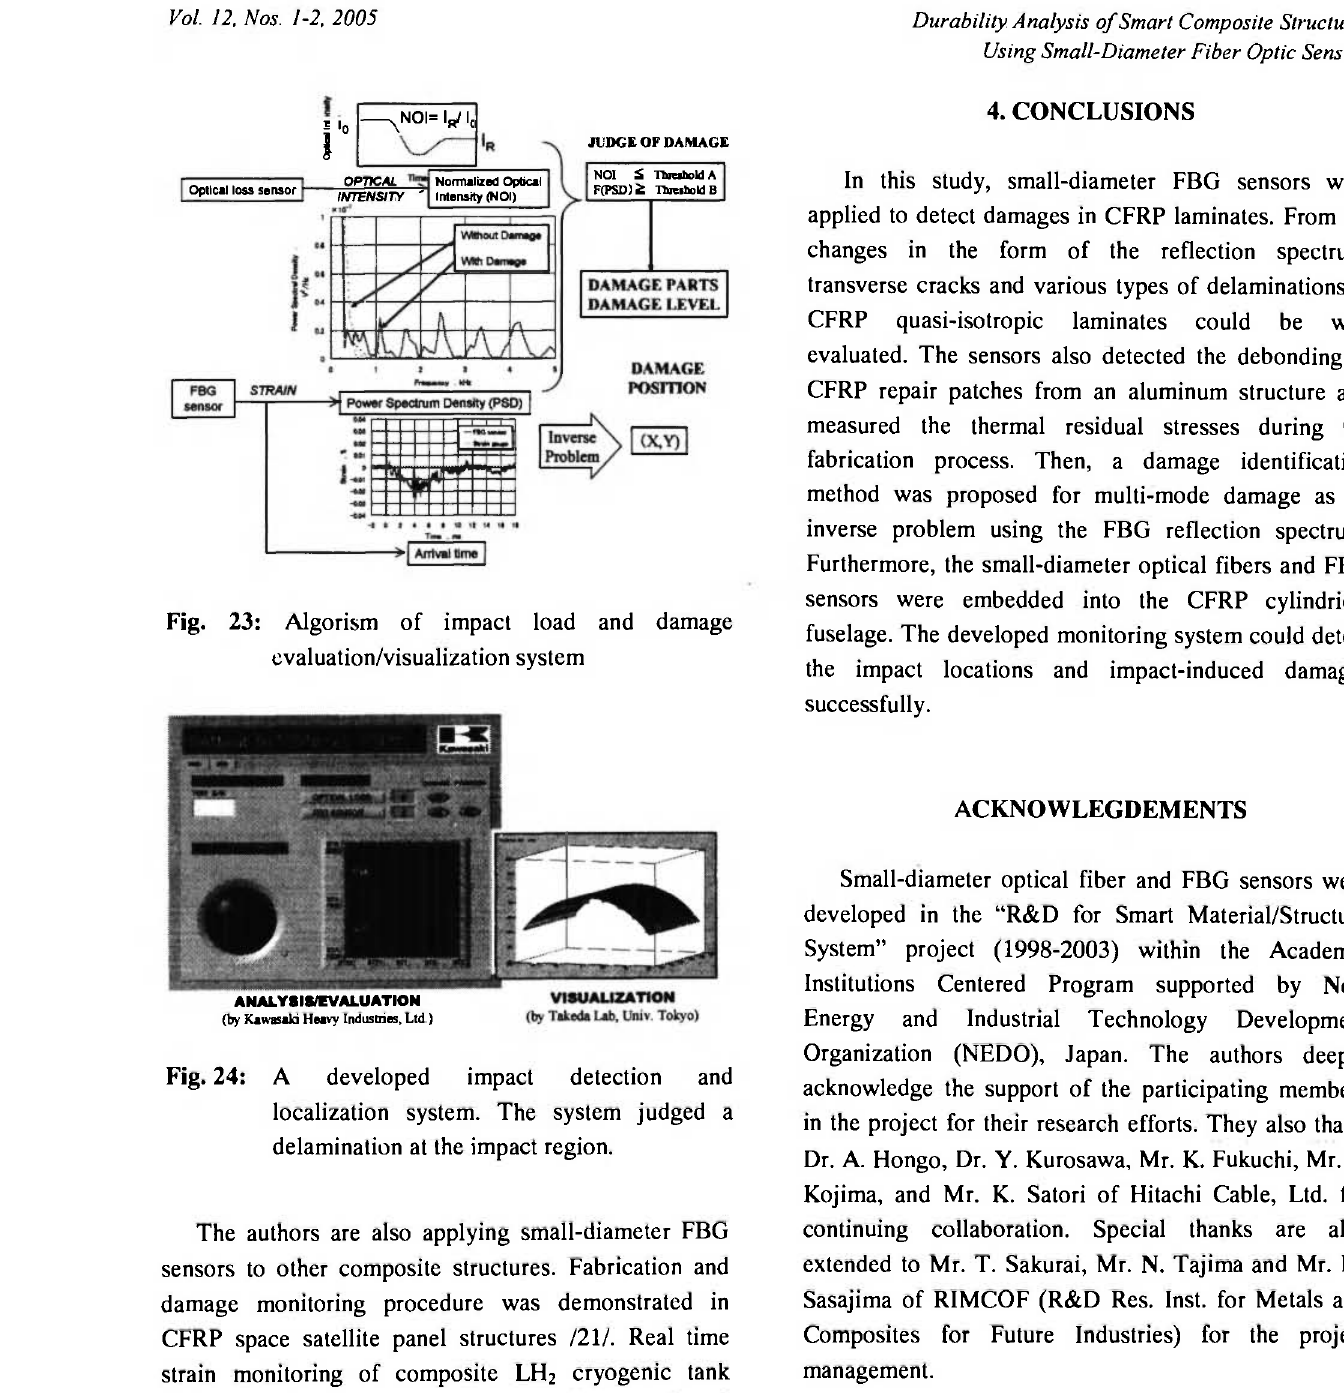
A developed impact detection and localization system. The system judged a delamination at the impact